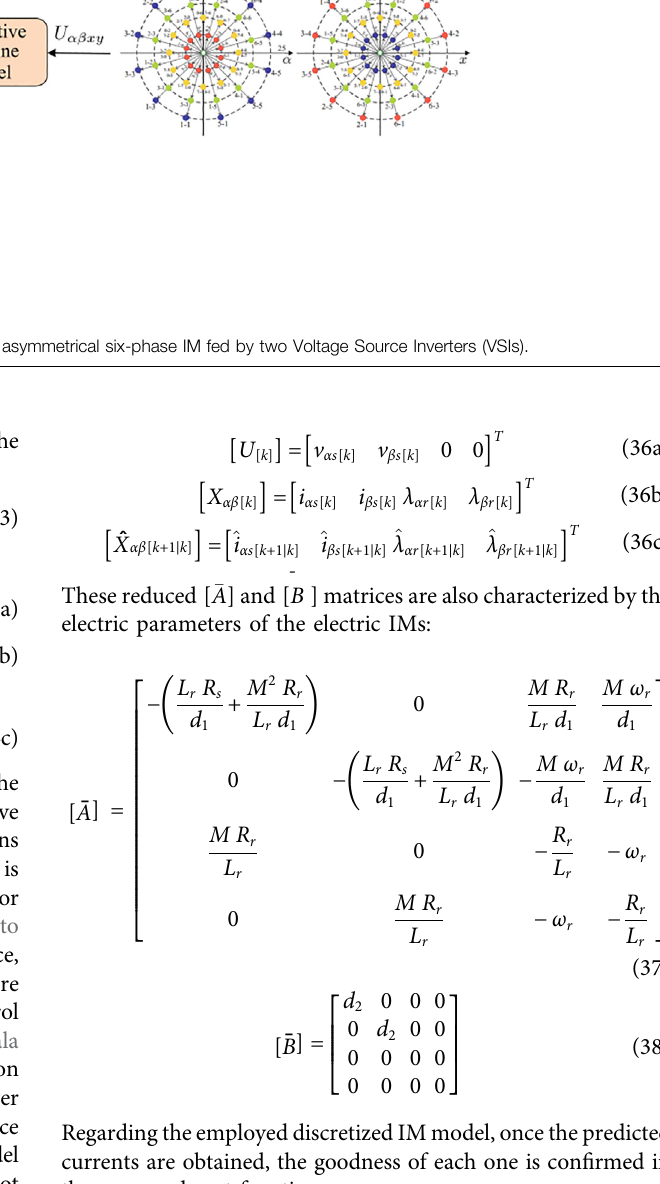
Frontiers in Energy Research |